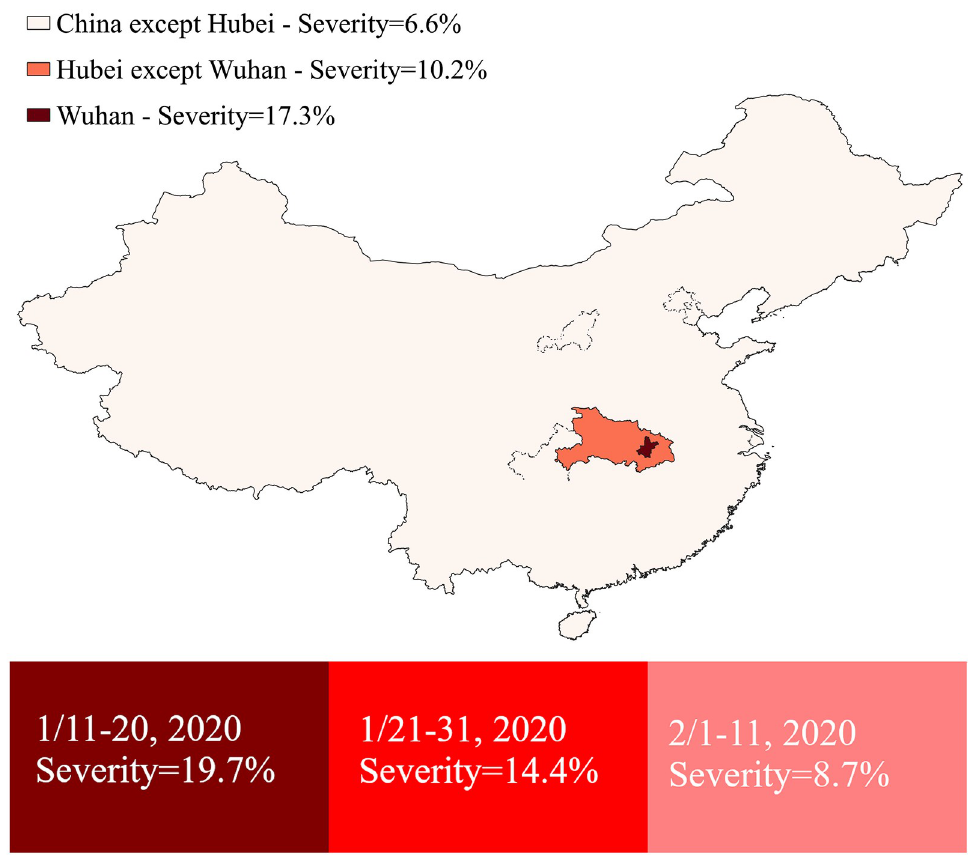
Fig 2. Percentage of COVID-19 infected healthcare workers in severe conditions in different geographic locations and over three ten-day periods, based on symptom onset dates. This map was created by authors with QGIS 3.12, using shapefiles available from The Humanitarian Data Exchange